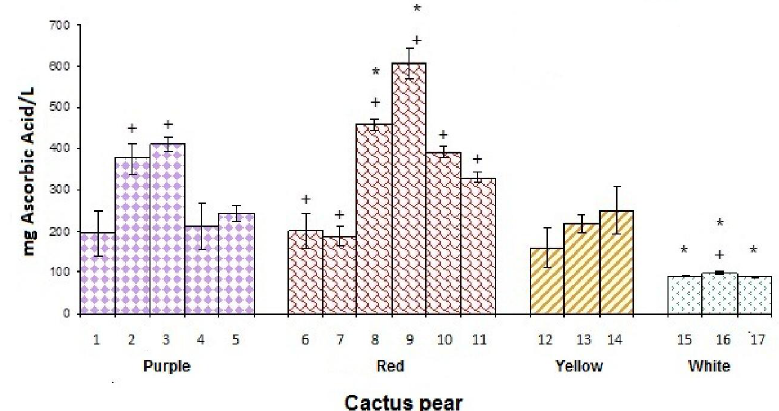
Figure 3. Ascorbic acid content of cactus pear studied cultivars. * denotes statistical significance at p < 0.05 among all studied cultivars of cactus pears. + indicates statistical significance at p < 0.05 among the cultivars of cactus pears in the same